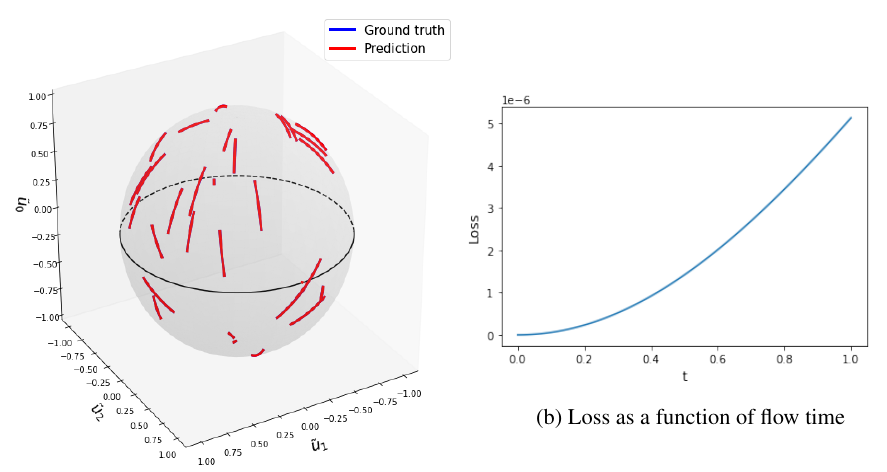
Figure 3: Test results. (a) Evolution of 30 samples projected on the three-dimensional sphere. The ground truth and the prediction lie on top of each other. (b) The corresponding Frobenius loss as a function of flow